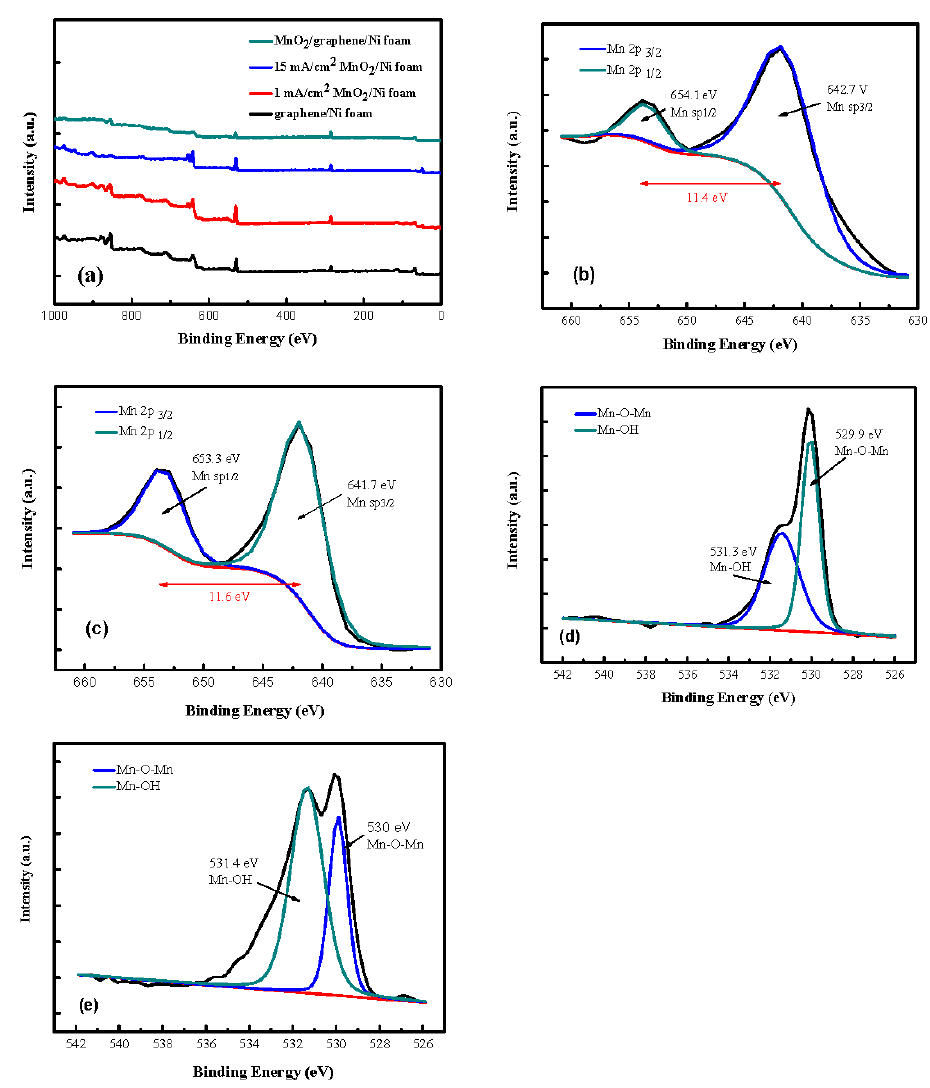
Figure 3. ( a ) The XPS full-spectrum of the MnO 2 /graphene/Ni electrode; ( b , c ) high-resolution Mn(2p) spectra of the MnO 2 /graphene/Ni electrode obtained at 1 mA cm − 2 and at 15 mA cm − 2 electrodeposition; and ( d , e ) high-resolution O(1s) spectra of the MnO 2 /graphene/Ni electrode obtained at 1 mA cm − 2 and at 15 mA cm − 2